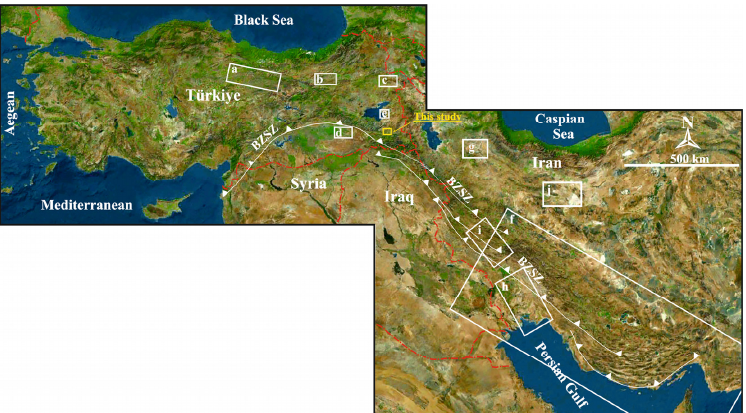
Figure 9. Relief map showing ( a – e ) Miocene evaporite fields in eastern Turkey, ( f ) Cambrian evaporite fields deposited along the Bitlis–Zagros Suture Zone (south–southeast Iran) and ( g – j ) Miocene evaporate fields in Iran. The boxes and the letters inside of them show the previous work in that area. ( a ): [103,113,115,116,119], ( b ): [123], ( c ): [106,107,117,122], ( d ): [109–111,118–120], ( e ):